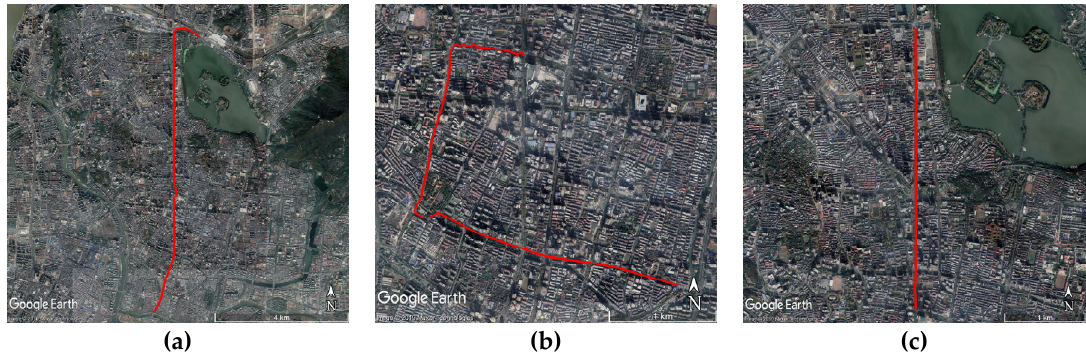
Figure 3. Vehicle routes corresponding to GNSS observations. ( a ) Vehicle route of the training set D1; ( b ) vehicle route of the test set D2; ( c ) vehicle route of the test set D3.